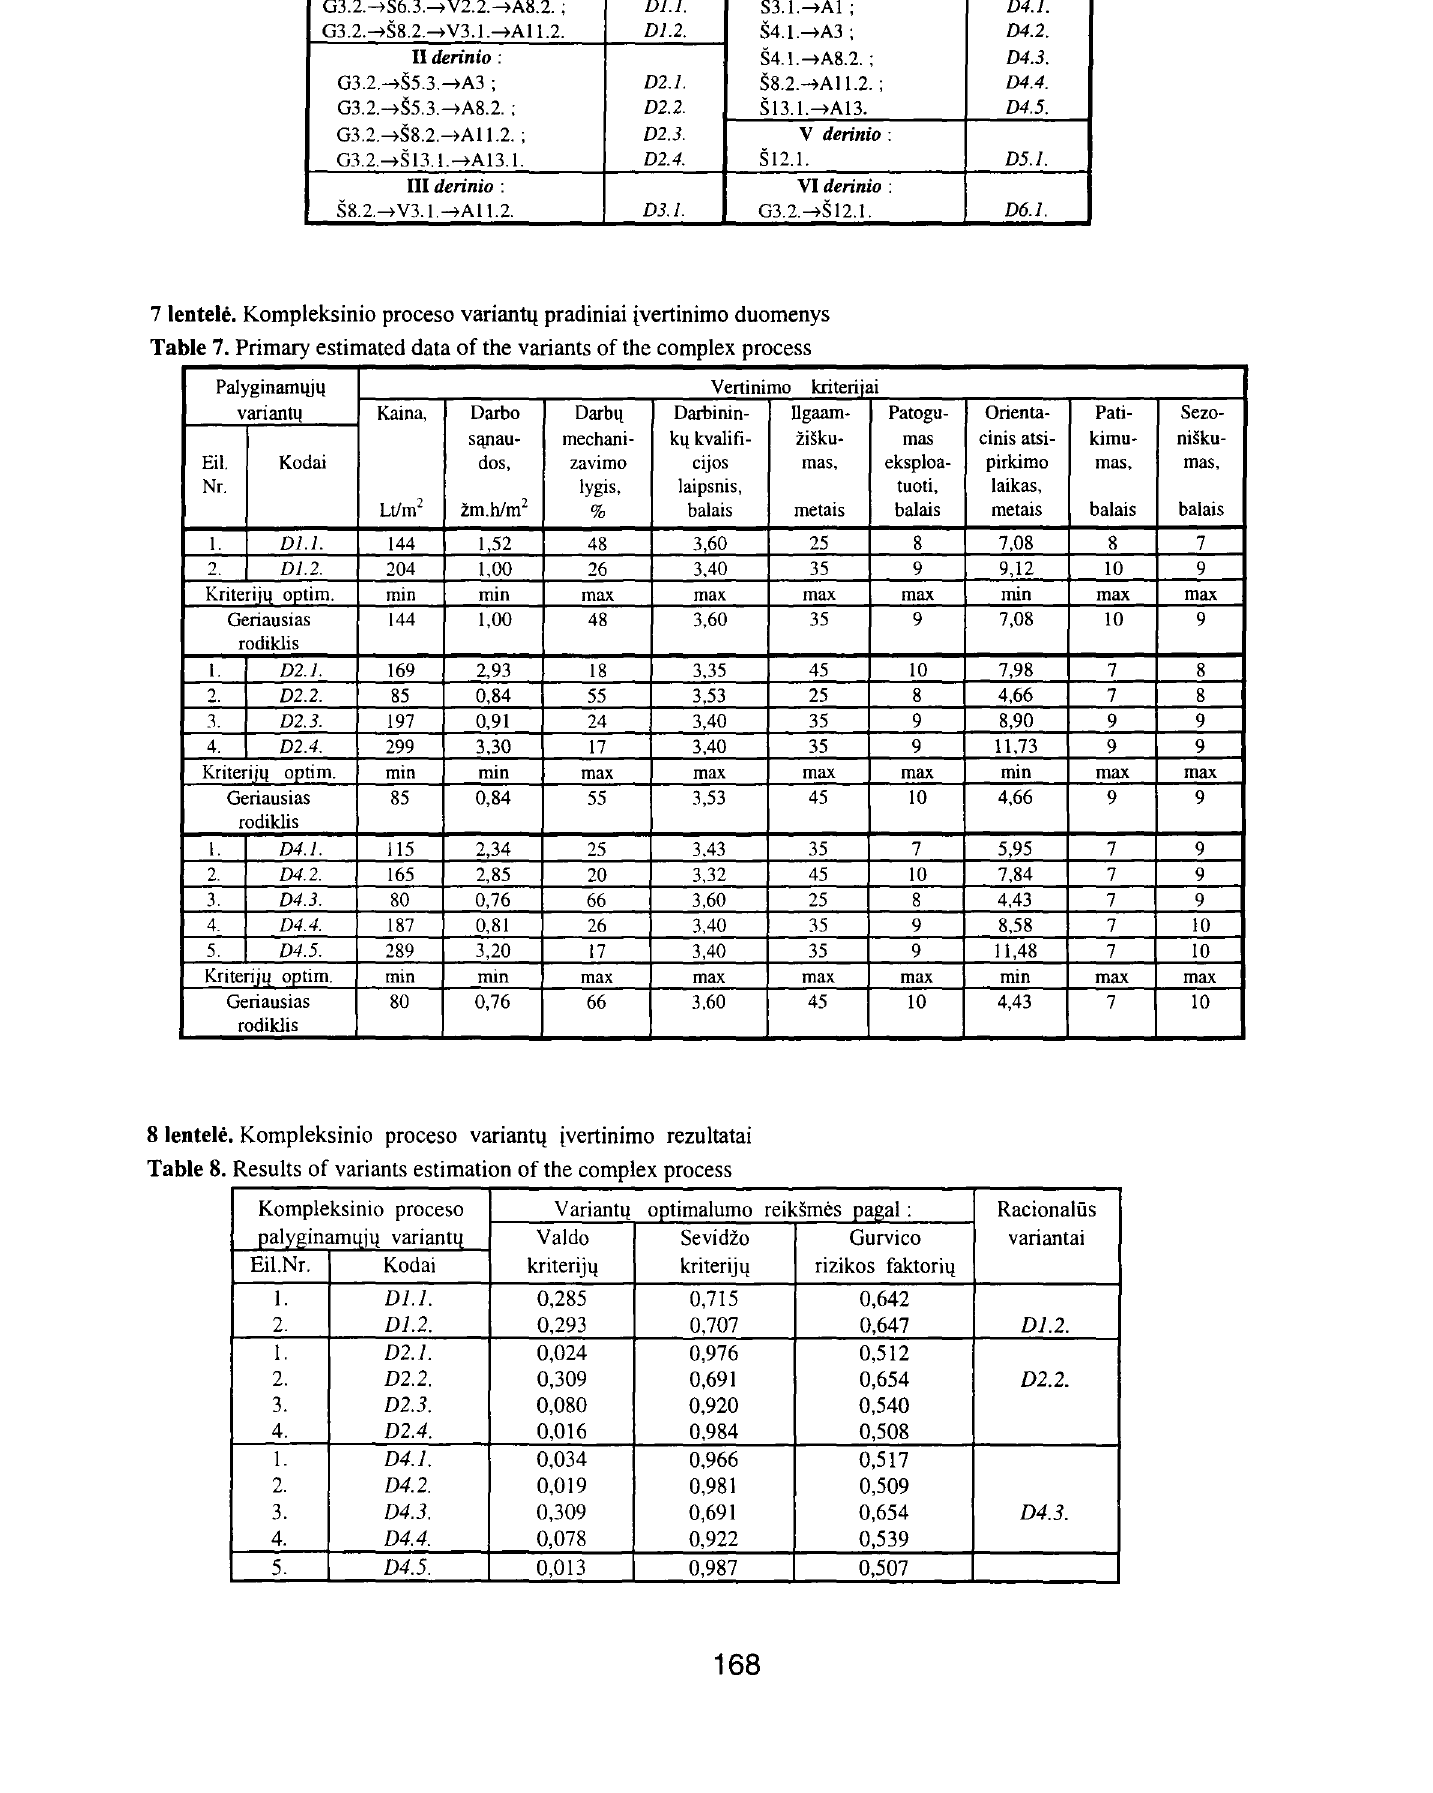
Table 7. Primary estimated data of the variants of the complex process Palyginarnt!ill Vertinimo kriterijai variant1.1